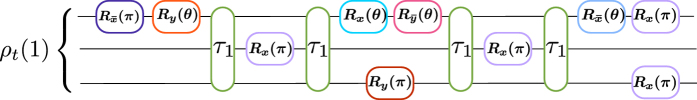
Quantum circuit representing the NMR pulse sequence for implementing the second collision.The input state is the resulting state from the first collision ρt(1). The boxes with the symbols Rα(θ) indicate that a rotation of the angle θ on that particular spin was performed around the α direction and . The boxes with the symbol τ1 represent a free evolution of the system and environment for a period of time τ1. τ1 is the time needed such that a rotation of π/2 occurs in the system and here it will be given by  s.